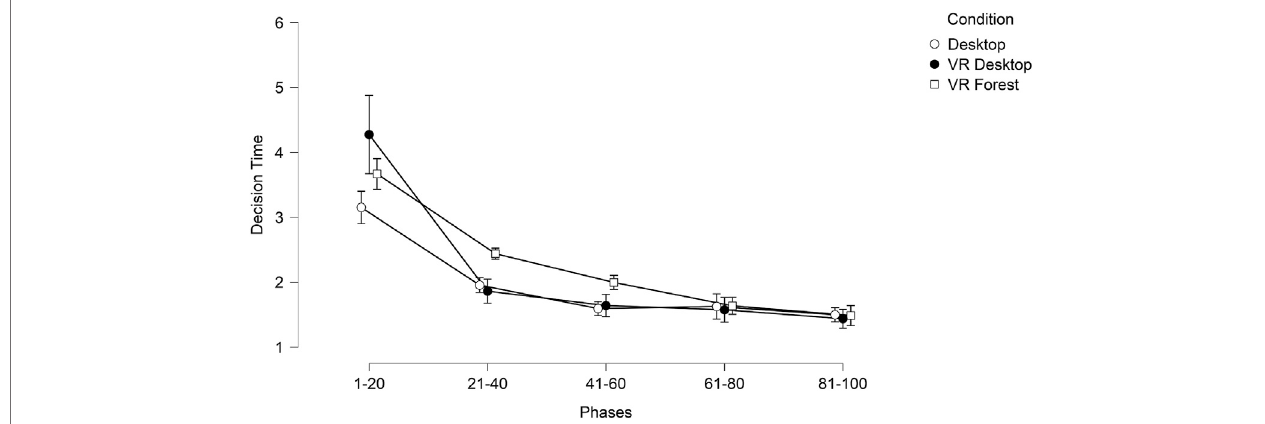
FIGURE 9 | Comparison of the mean decision time per 20 game rounds. The error bars denote the standard error.